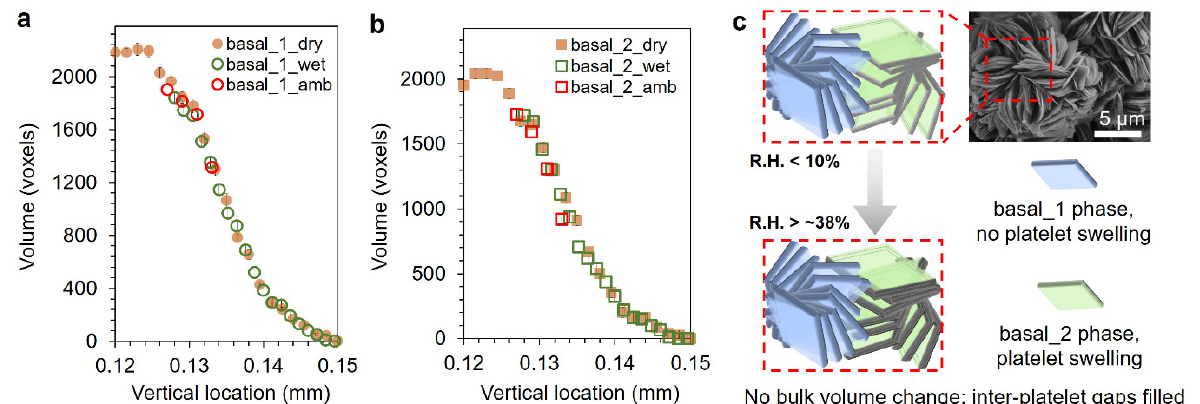
Figure 10. (a) The total volume (in voxel counts) of phase basal_1 and (b) basal_2 at each vertical slices of the studied sub ‐ volume as a function of the moisture condition. The proposed micro ‐ morphological change of the ASR product vein during wetting (adapted from